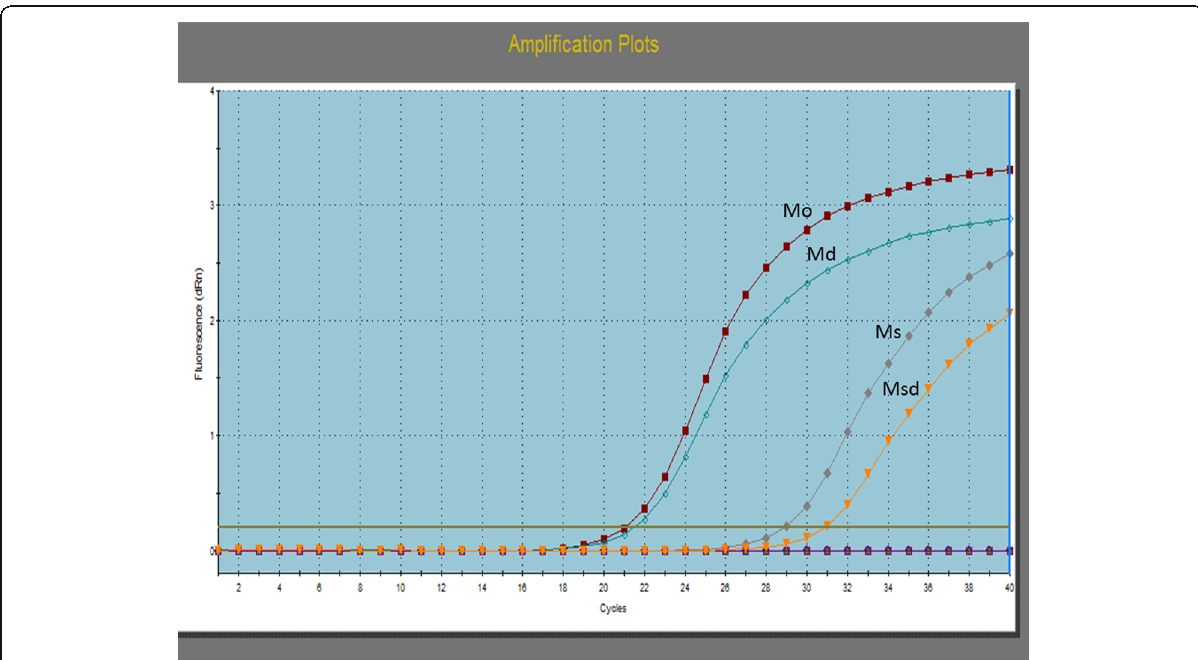
Fig. 1 Amplification curve. M0: DNA without digestion. Ms: methylation-sensitive restriction enzyme used. Md: using methylation-dependent Msd: double restriction endonuclease